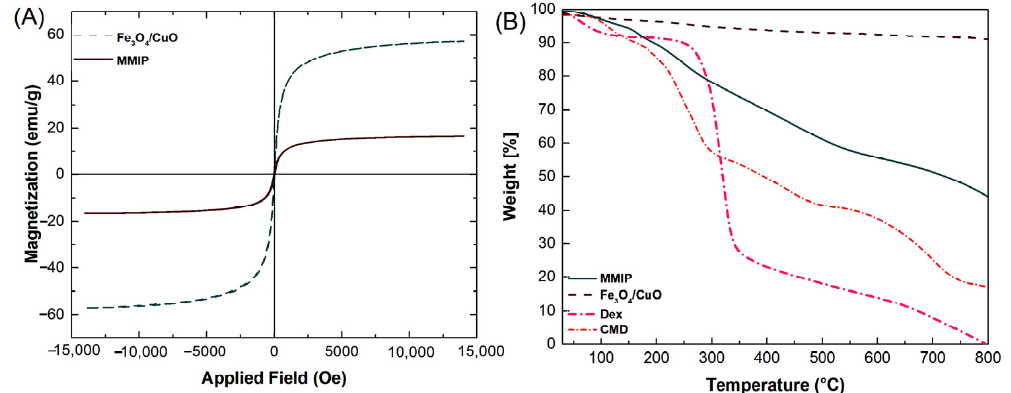
Figure 4. VSM curves of Fe 3 O 4 /CuO and magnetic molecularly imprinted polymer (MMIP) ( A ), and TG thermograms of dextrin (Dex), CMD, Fe 3 O 4 /CuO, and MMIP ( B ). BET : Brunauer–Emmett–Teller (BET) analysis was employed to study the textural properties, porous structure, and specific surface area of the Fe 3 O 4 /CuO and MMIP. The